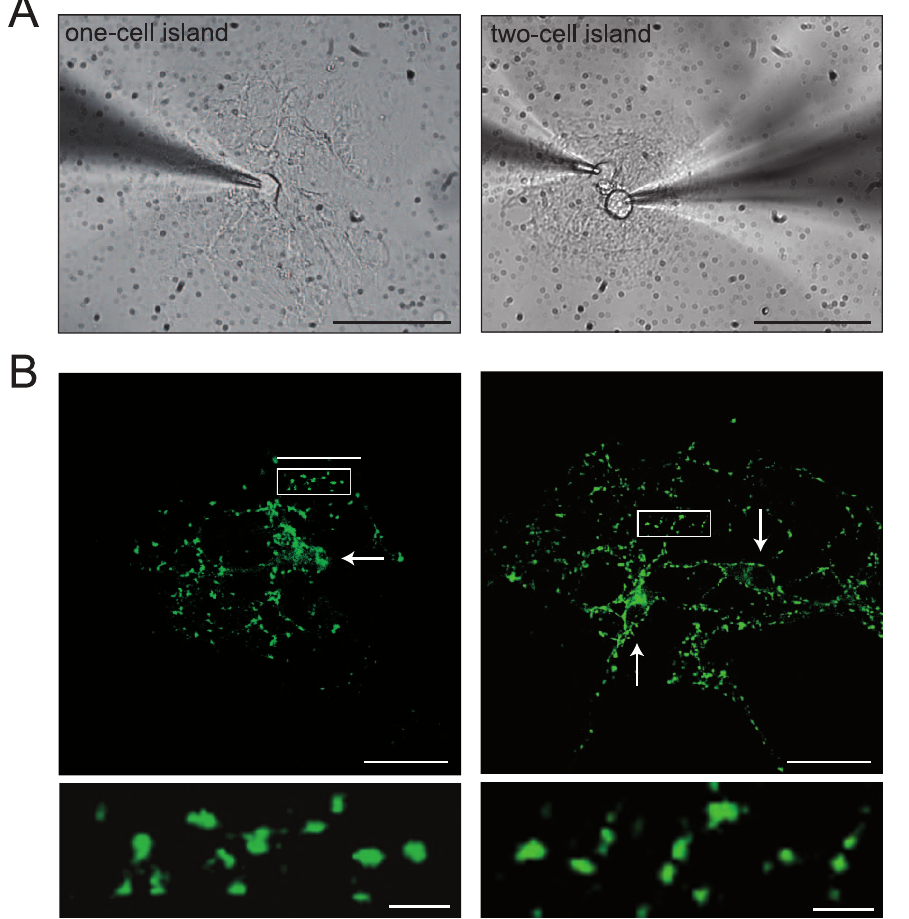
Figure 2. The number of synapses per neuron is constant in one and two-neuron micronetworks. (A) Bright-field images of one- and two-neuron micronetworks with patch clamp recording electrodes in place. Scale bars are 40 m m. (B) VGluT1 immunostaining of glutamatergic synapses in microislands containing one or two neurons (white arrows). The lower panels are enlarged images of the indicated rectangular areas D, The number of synapses in one- and two-neuron microislands is indicated: 330 6 70 synapses in one-neuron islands (n=9), and 750 6 120 synapses in two-neuron islands (n=7). Scale bars are 40 m m in upper panels and 5 m m in lower panels.